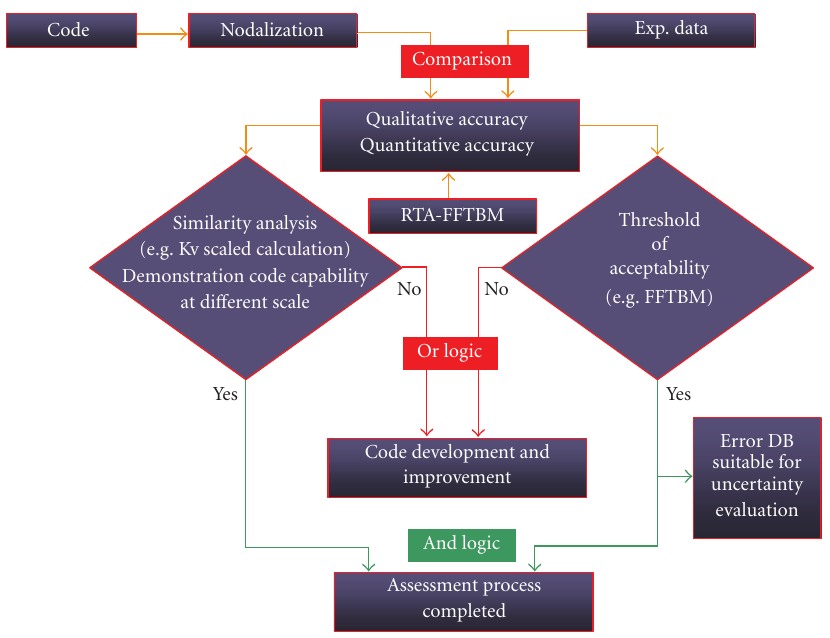
Figure 4: Code independent